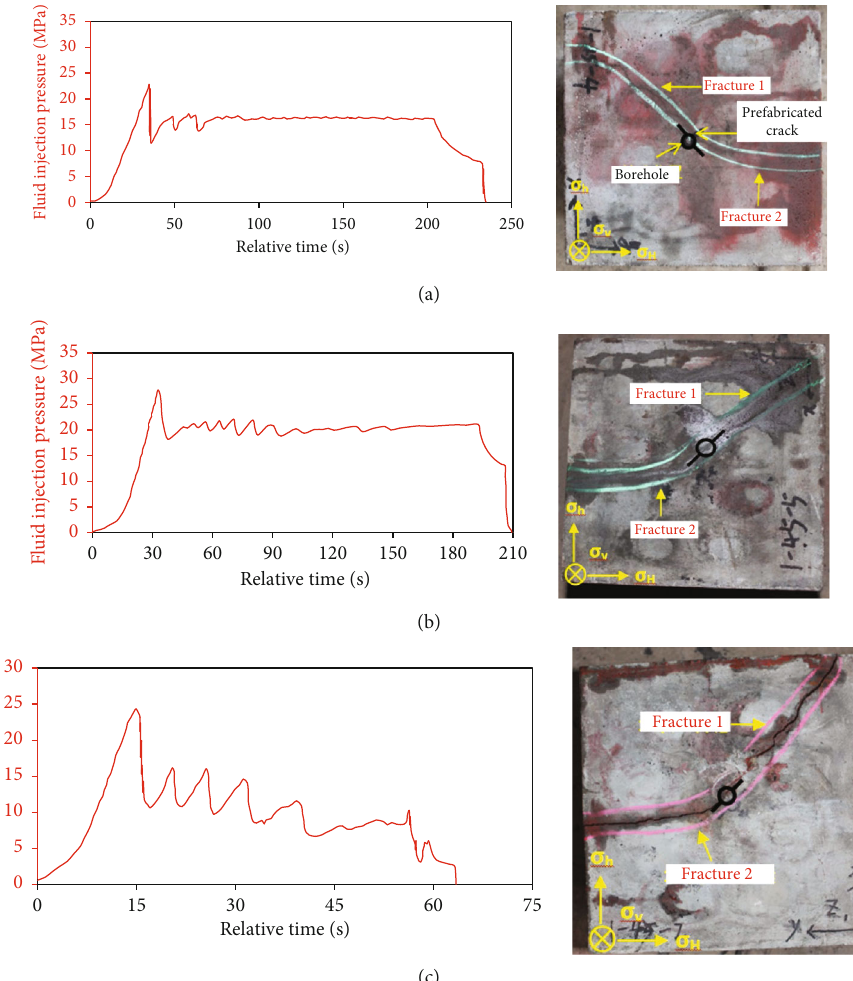
Figure 10: Injection pressure curves and de fl ecting HF geometries at di ff erent injection rates (replotted based on the experimental results of Lin et al. [8]): (a) 1.0ml/s; (b) 1.5ml/s; (c)